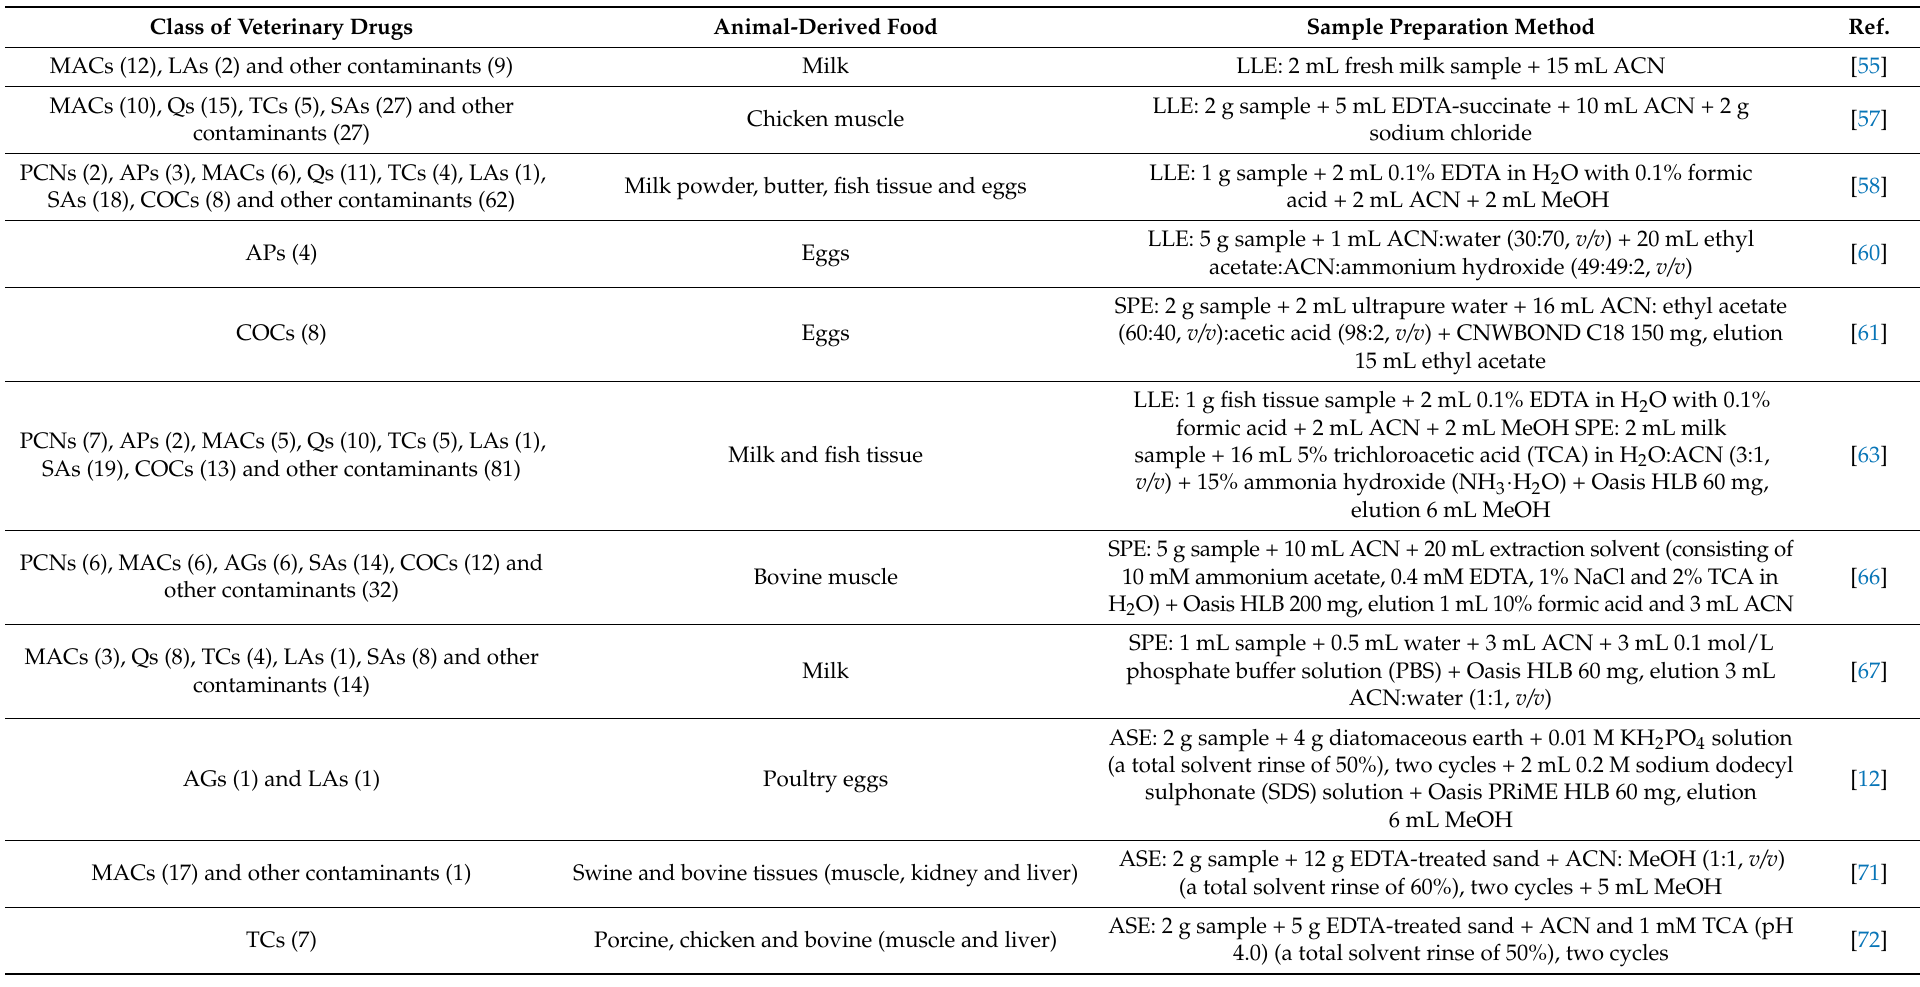
Table 3. Sample preparation techniques for the detection of veterinary drugs in animal-derived food